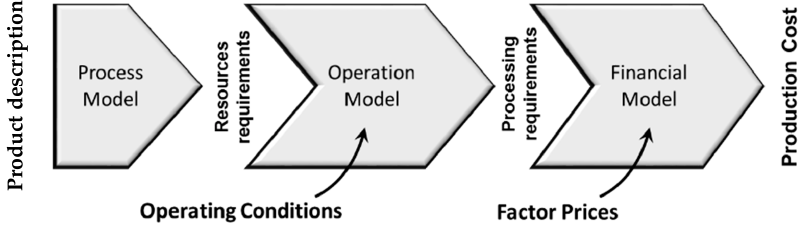
Figure 1. The Process-Based Cost Modeling (PBCM) elements’ decomposition.